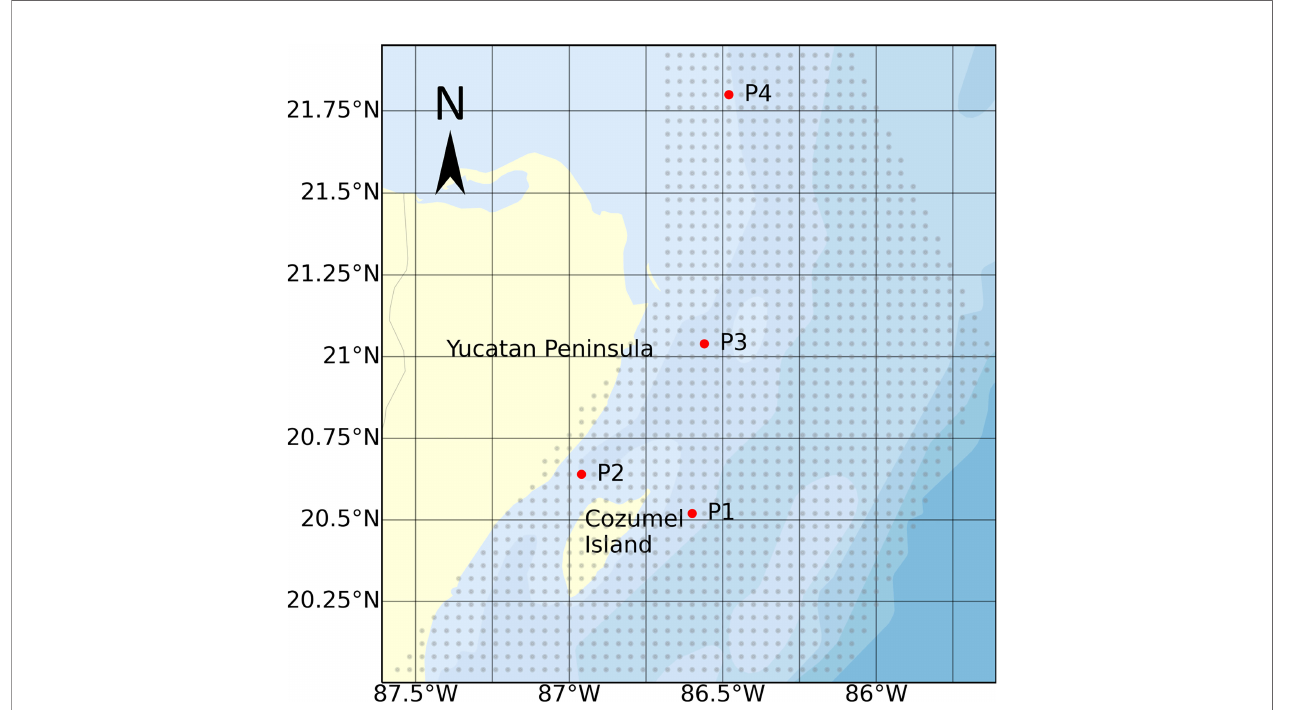
FIGURE 4 | Location of the nodes for the numerical model which lie within the study area. The nodes marked in red are positions for which more details regarding the GPD fi t are